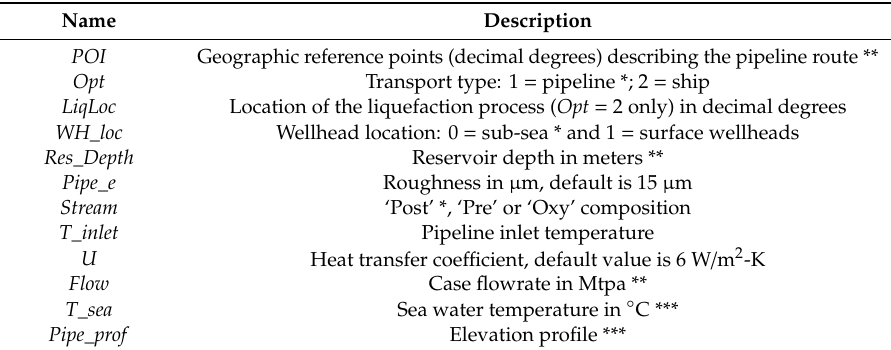
Table 2. Summary of Model Input Parameters.